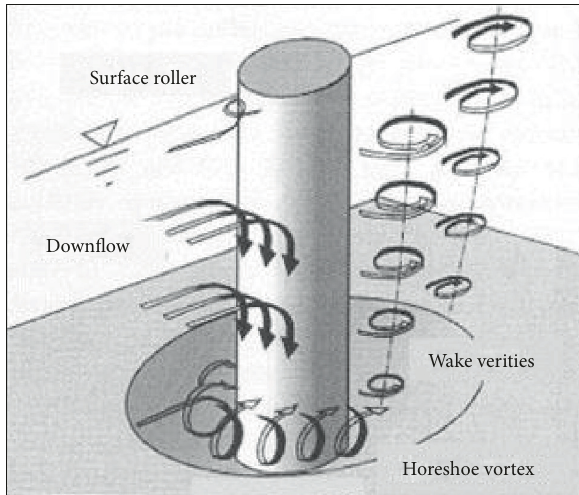
Figure 1: Fluid behavior near the pier with scour